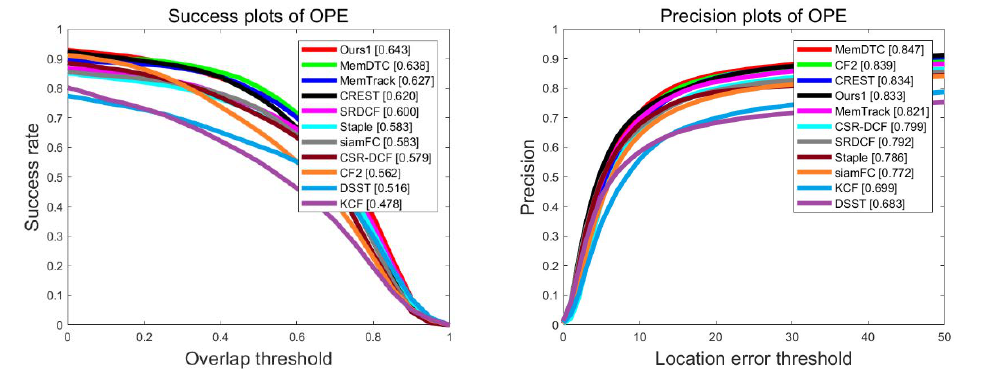
Figure 7. Success and precision rates on the OTB100